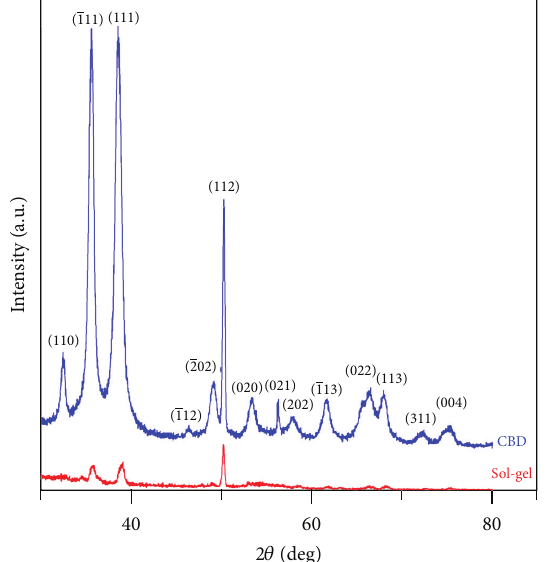
Figure 2: XRD patterns of the CuO films.